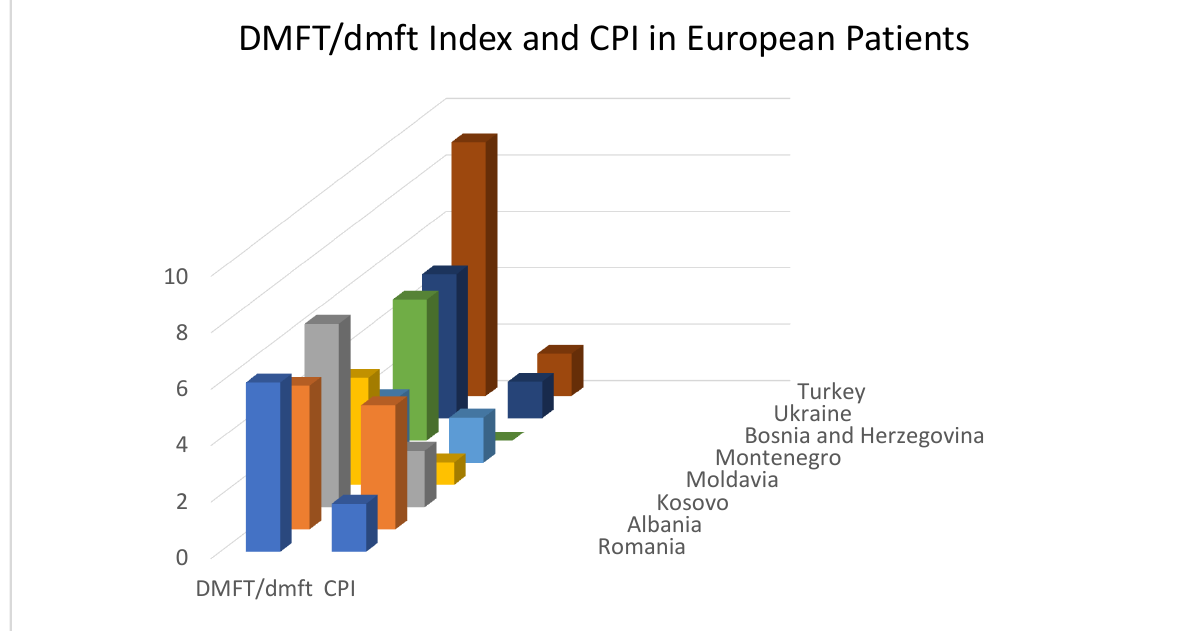
Figure 3. DMFT/dmft Index and CPI (means) in European patients.